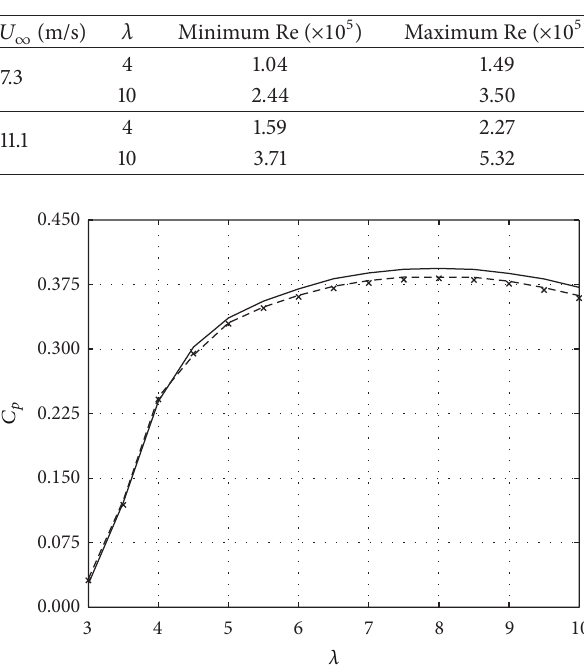
Table 5: Maximum and minimum Re seen by the aerodynamic span of the blade at 𝜆 = 4 and 𝜆 = 10 with 𝑈 ∞ = 7.3 m/s and 𝑈 ∞ = = 7 , AERODAS, tip loss model on. 11.1 m/s. Model input: 𝑁 crit